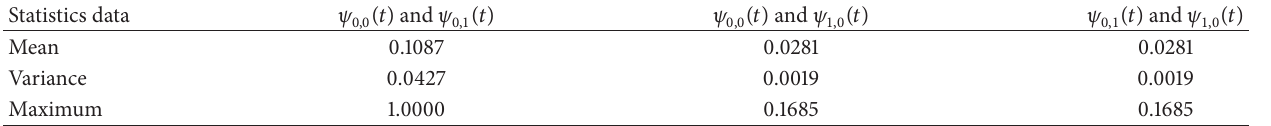
Table 5: Statistics of asynchronous mutual correlation values for Meyer wavelet.